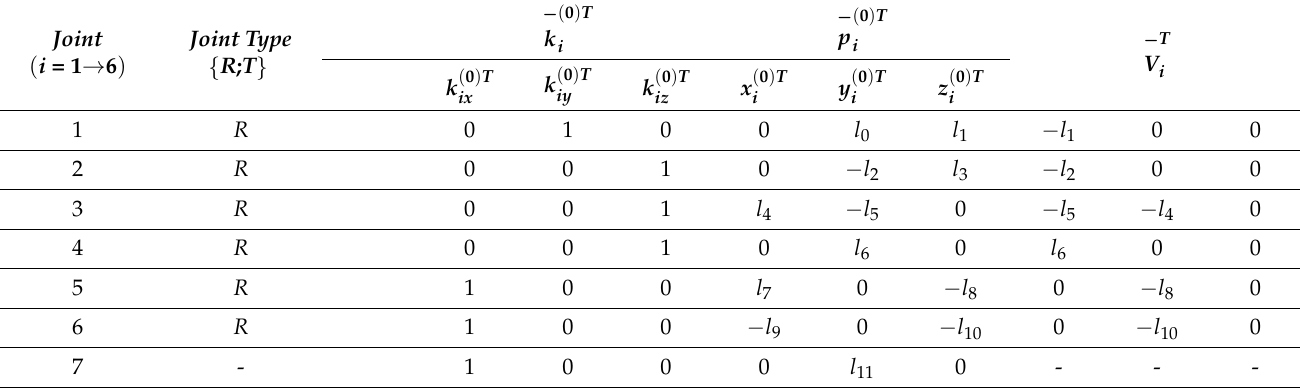
Table 1. The geometrical characteristics of CardioVR − ReTone 6R